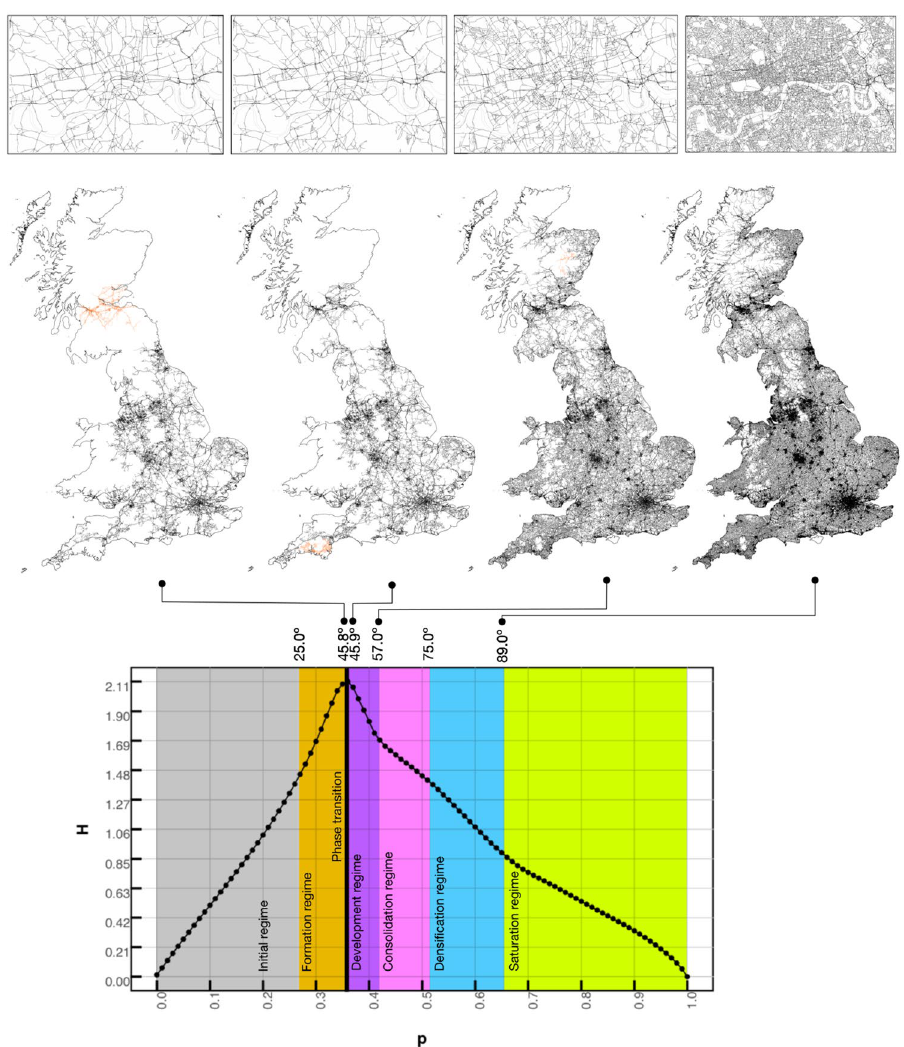
Figure 1. Shannon’s entropy of the distribution of the cluster sizes. We can clearly see 6 different regimes in the way the system behaves. Upper panel, zoom into the center of London. Center panel, giant cluster in black, second largest cluster in orange. Lower panel, entropy measurement and the different